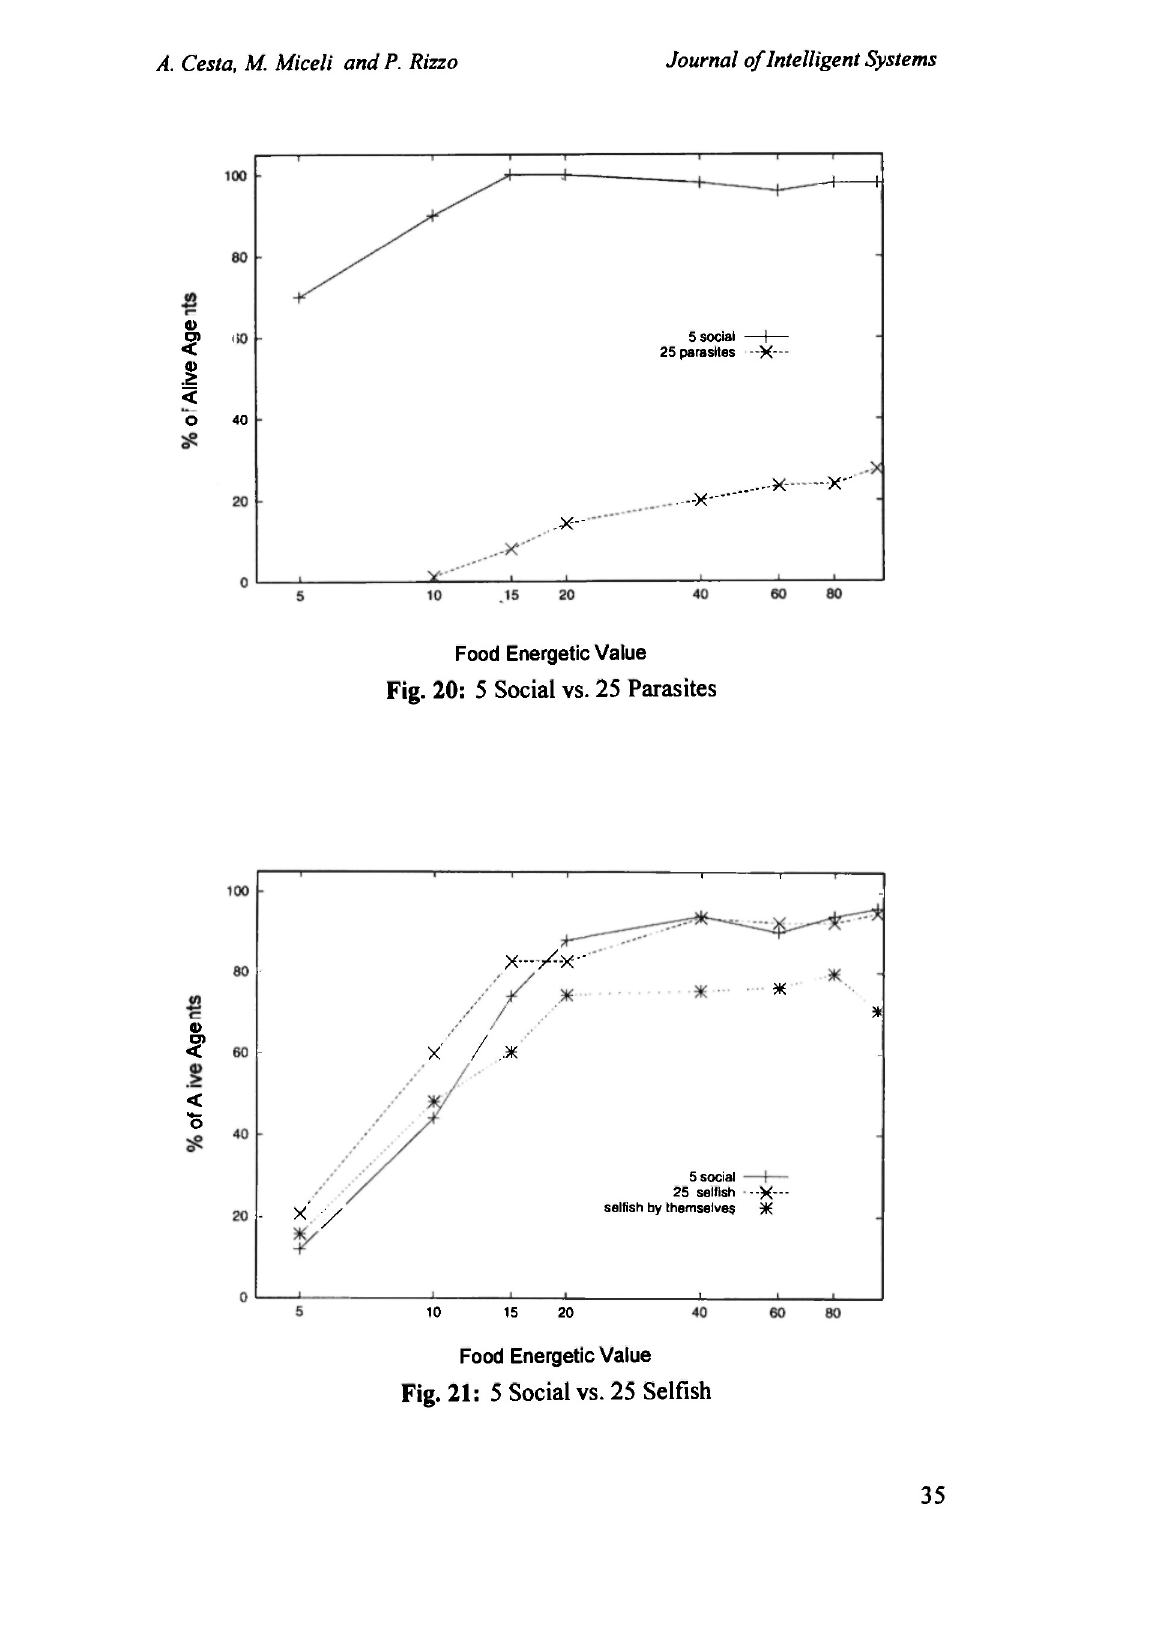
Fig. 21: 5 Social vs. 25